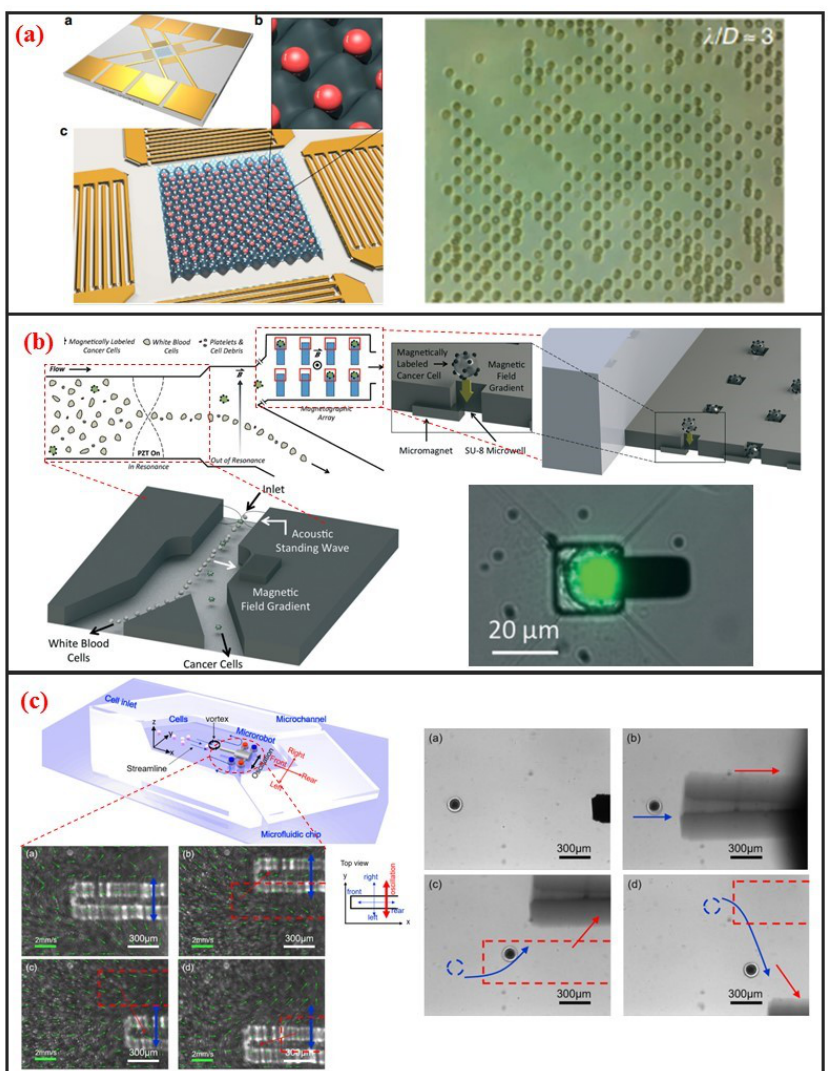
Figure 7. Acoustic, magnetic and microrobot single-cell manipulation methods and some designs. ( a ) Surface acoustic waves based single-cell pattern. Adapted by permission from Reference [23],